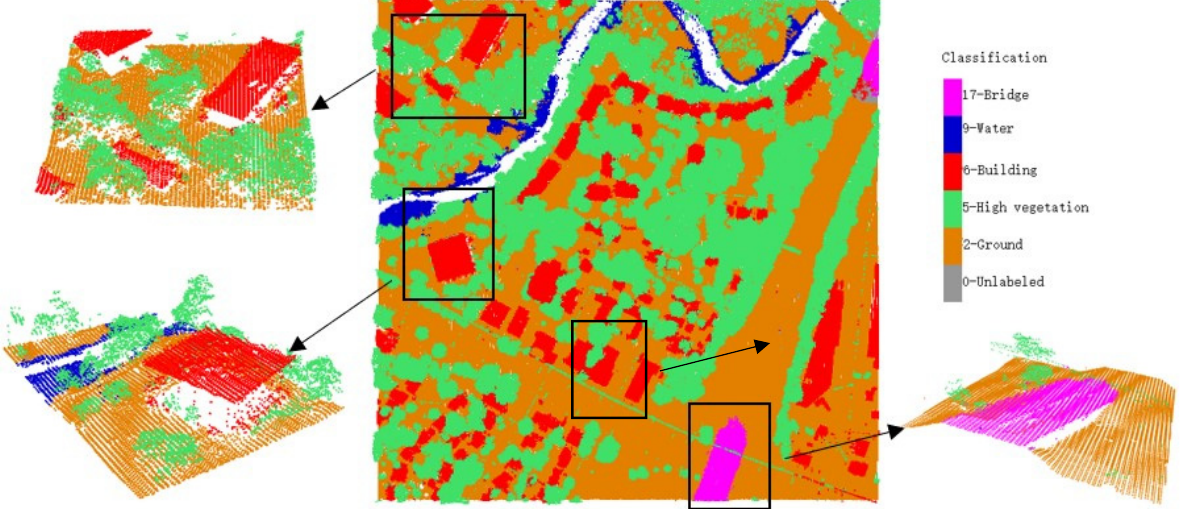
Figure 10. The classification results of our method on one tile of the DFC 3D test set.